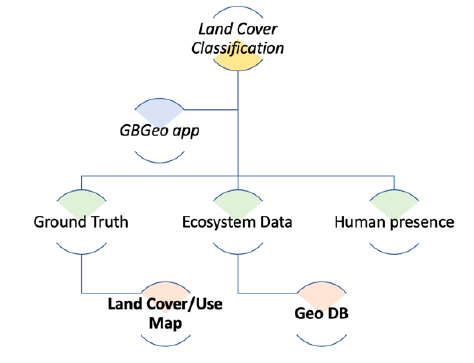
Figure 3. Workflow of the approach.